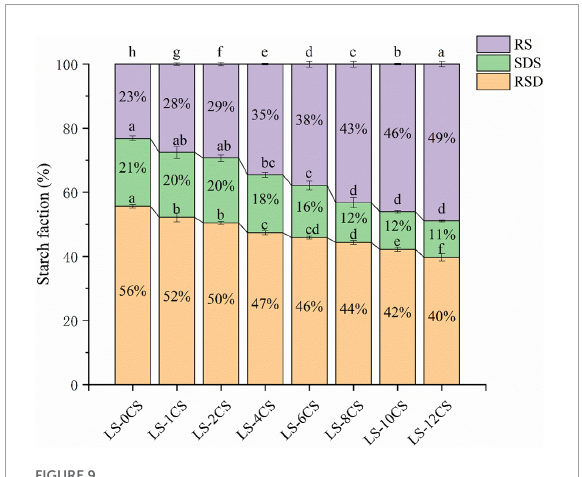
FIGURE9 RDS, SDS, and RS contents of lotus seed cross-linked resistant starch samples. Different lowercase letters represent significant differences ( p <